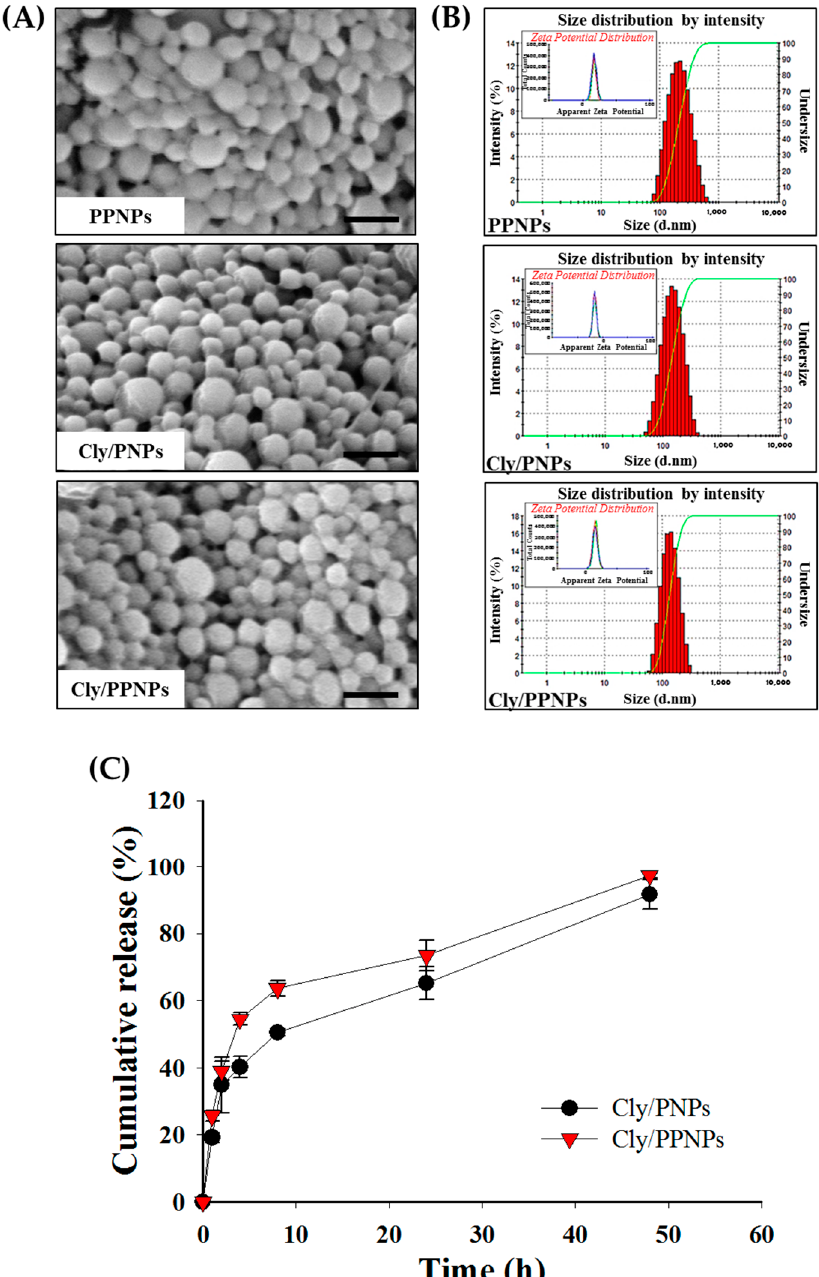
Figure 2. Characterization of NPs. ( A ) Scanning electron microscope (SEM) images of PPNPs, Cly/PNPs, and Cly/PPNPs; bars represent 300 nm. ( B ) Size distribution of PPNPs, Cly/PNPs, and Cly/PPNPs by zetasizer nano series ZS90; insets represent zeta potential measurement. ( C ) In vitro release profile of Cly/PNPs, and Cly/PPNPs. All samples were placed in phosphate buffered saline (PBS) pH 7.4 at 37 °C; data are means ± SD; n = 3.